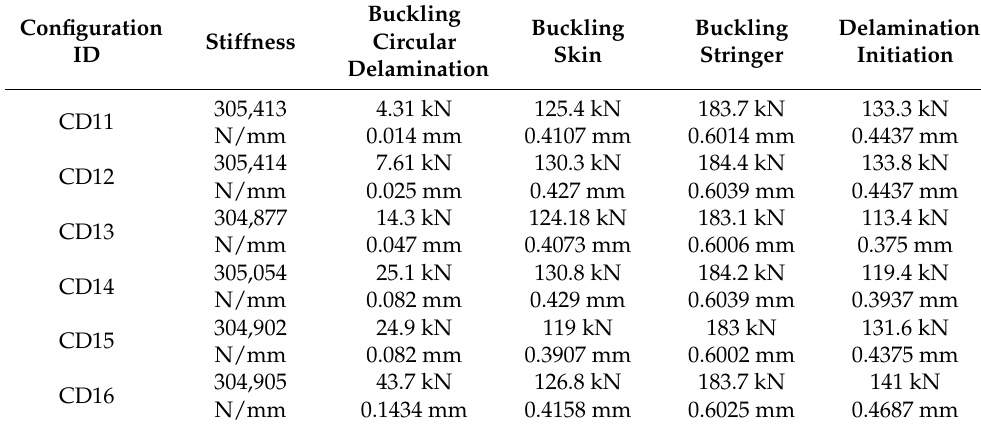
Table 6. Buckling loads and displacements for CD11–CD16